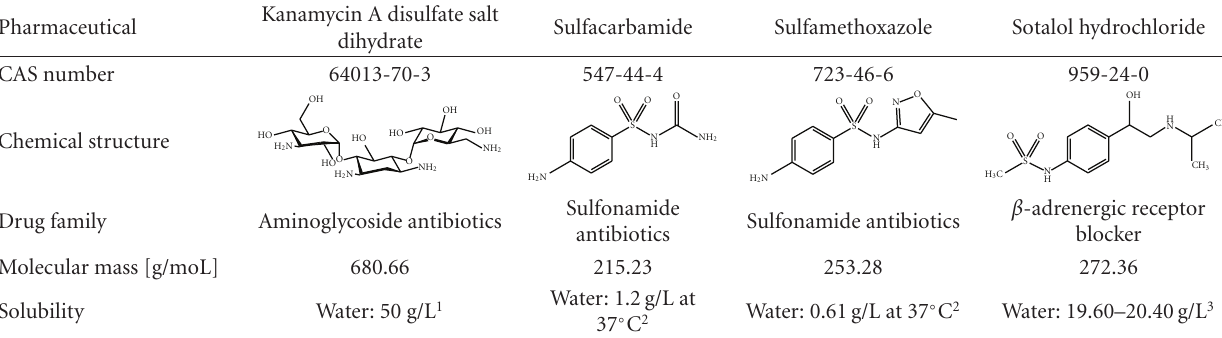
Table 1: Characteristics of the four pharmaceuticals used in the Capture-SELEX process as target mixture. Pharmaceutical